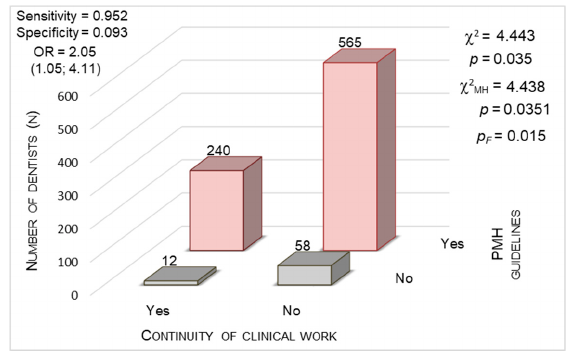
Figure 7. Continuity of clinical work during the COVID-19 outbreak vs. acknowledgment of Polish Dental Association (PDA) guidelines ( p < 0.0001, chi-square test).